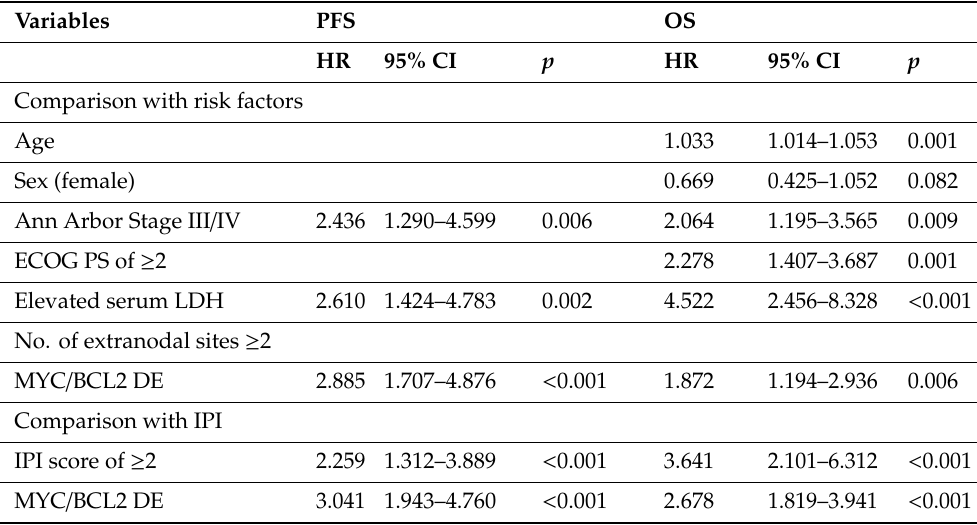
Table 3. Multivariate analysis of OS and PFS according to clinicopathological parameters in DLBCL patients treated with